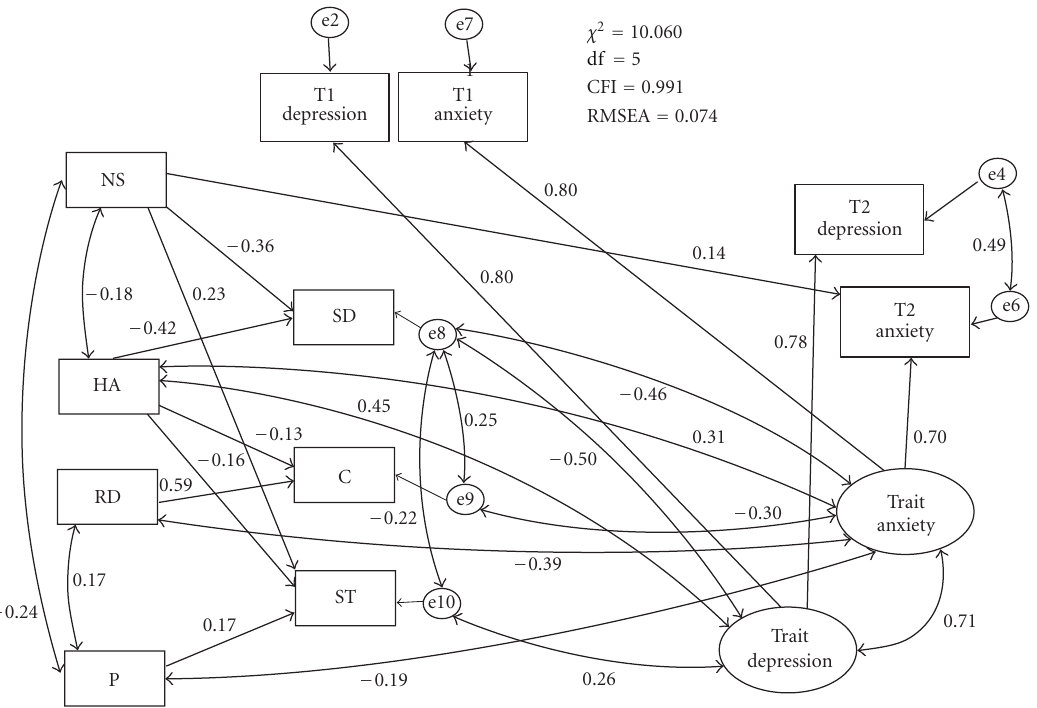
Figure 2: Final SEM model NS: novelty seeking; Ham: harm avoidance; RD: reward dependence; P: persistence; SD: self-directedness; C: cooperativeness; ST: self-transcendence. Paths without significance ( < 0.05) are not shown in the Figure (but were not deleted).